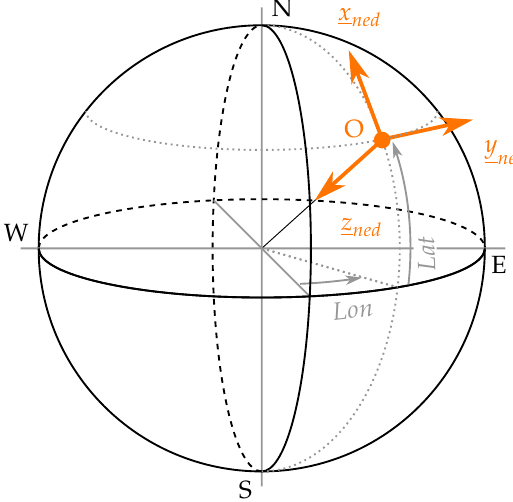
Figure 3. Drawing of the North East Down R ned reference